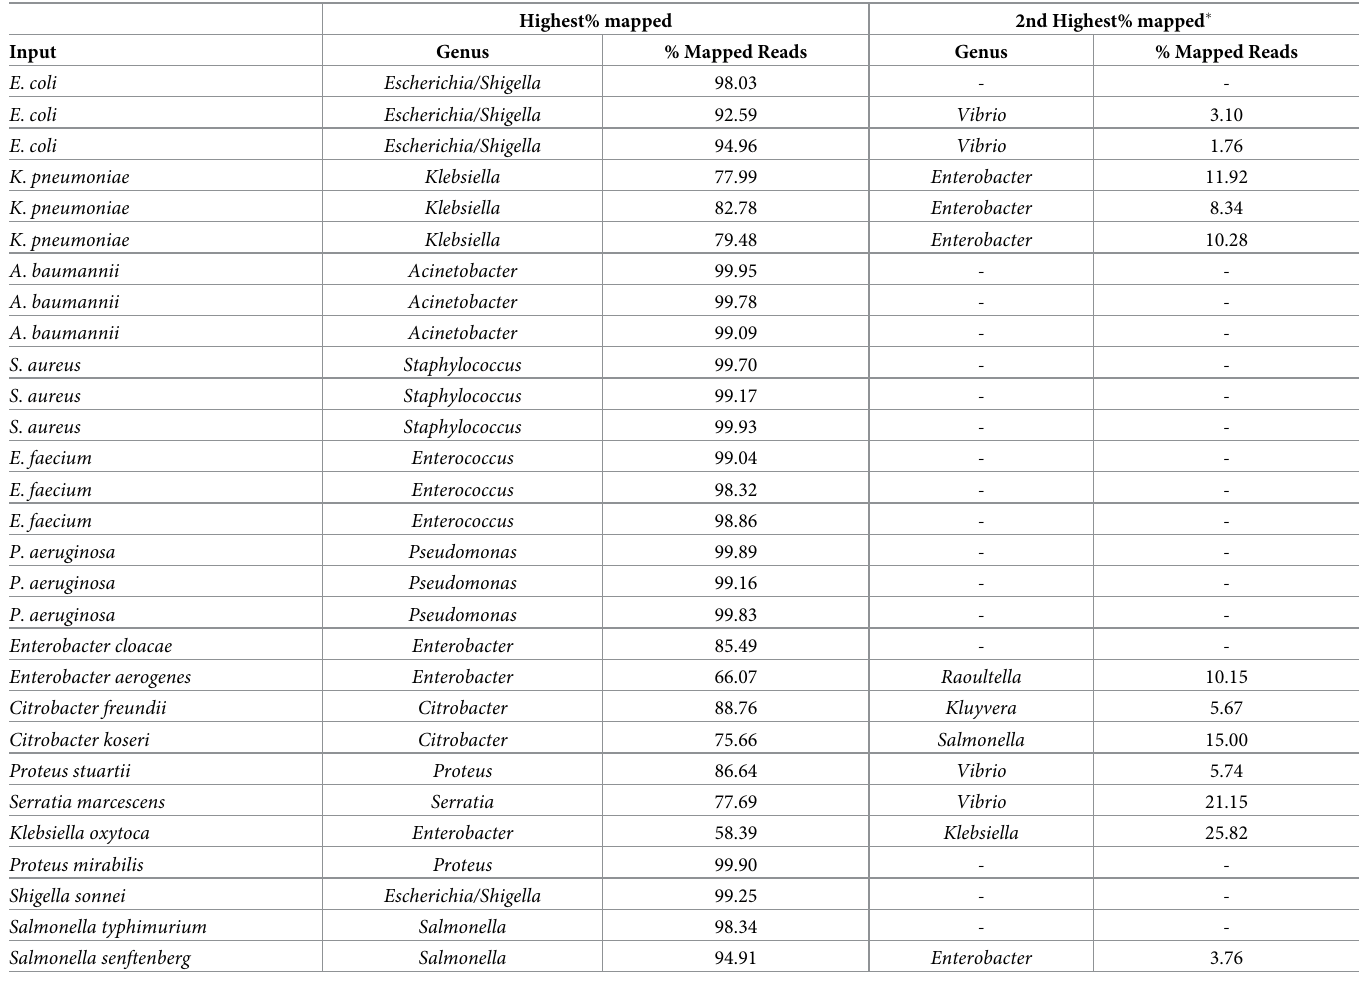
Table 3. Read mapping of sequenced qPCR